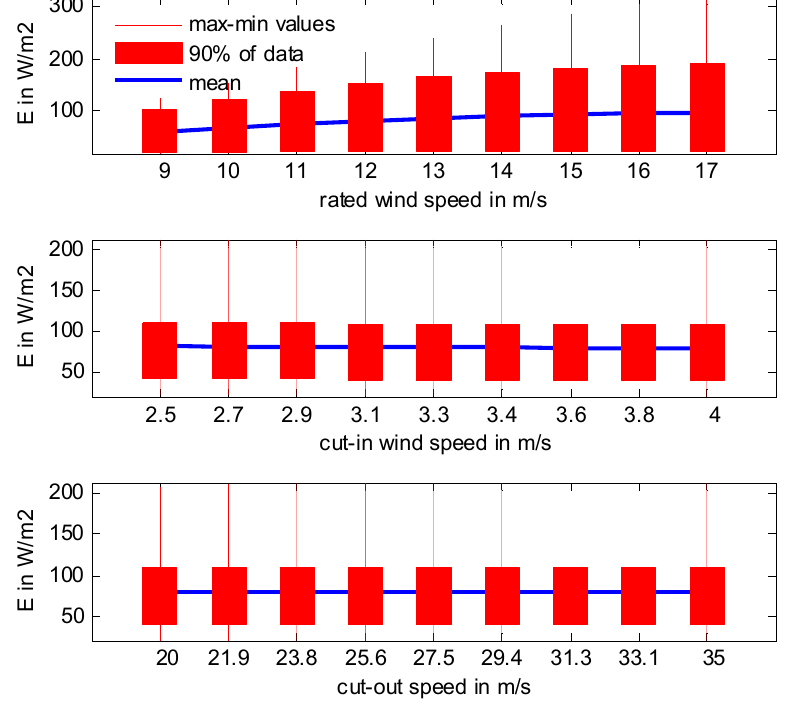
Figure 5. Candlestick chart with the power density at the considered wind sites for different values of rated, cut-in and cut-out wind